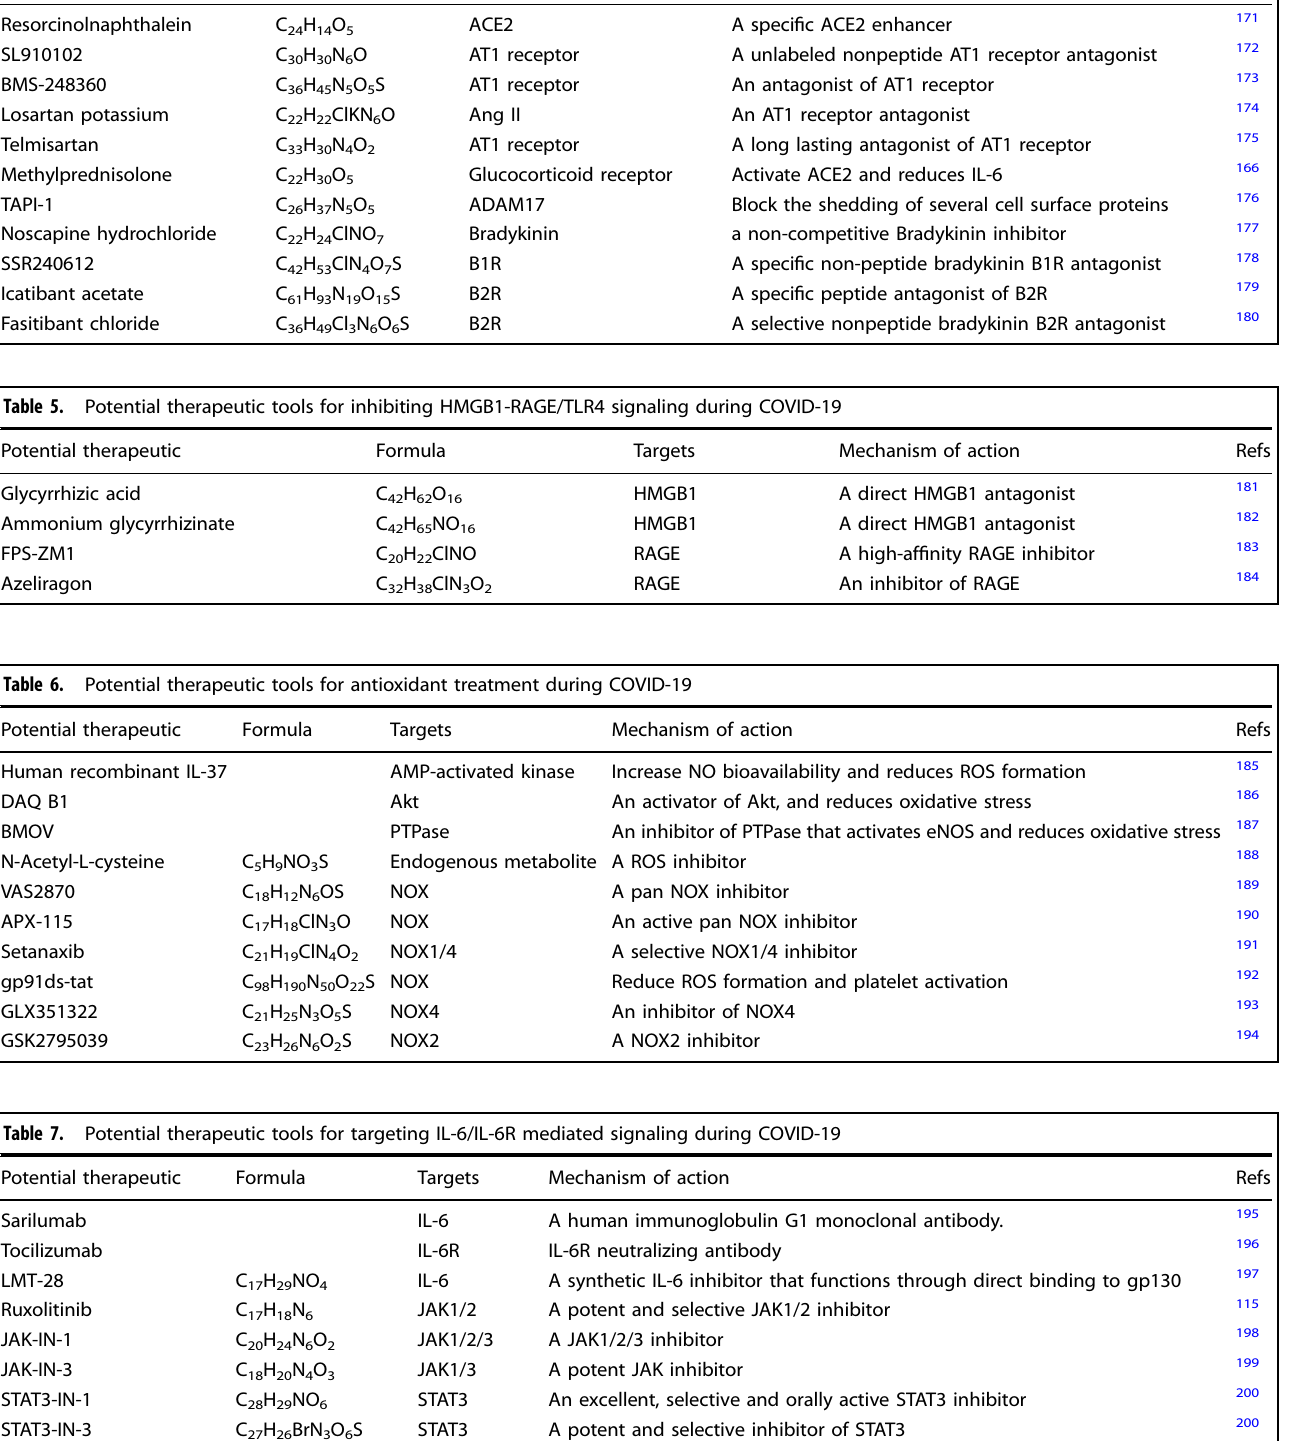
survival, migration, and permeability. 116 VEGFA/VEGFR2 recruits the TSAd adapter protein complex, which regulates VEGFA- induced activation of Src tyrosine kinase and vascular permeability in blood vascular ECs (Fig. 3). 116 Notably, VEGFA is upregulated in the lungs of infections who have died from COVID-19. 63